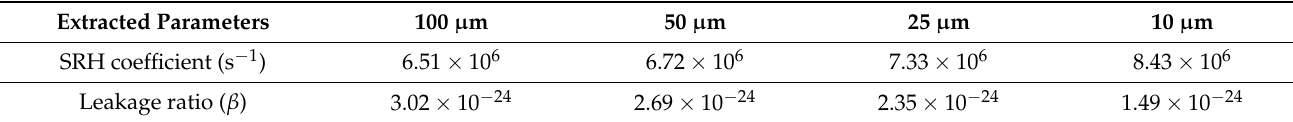
Figure 4. The measured (dots) and the calculated (line) results of devices of ( a ) 100 μm, ( b ) 50 μm, ( c ) 25 μm, ( d ) 10 μm.